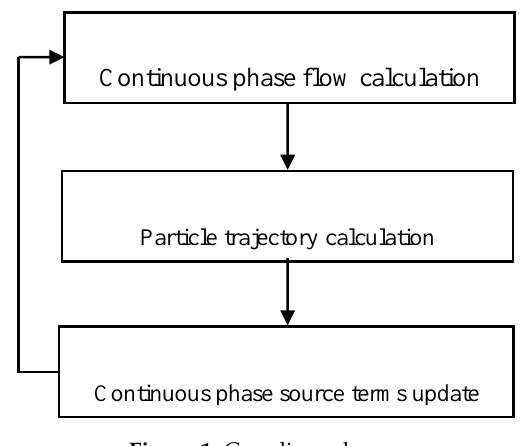
Figure 1. Coupling scheme.